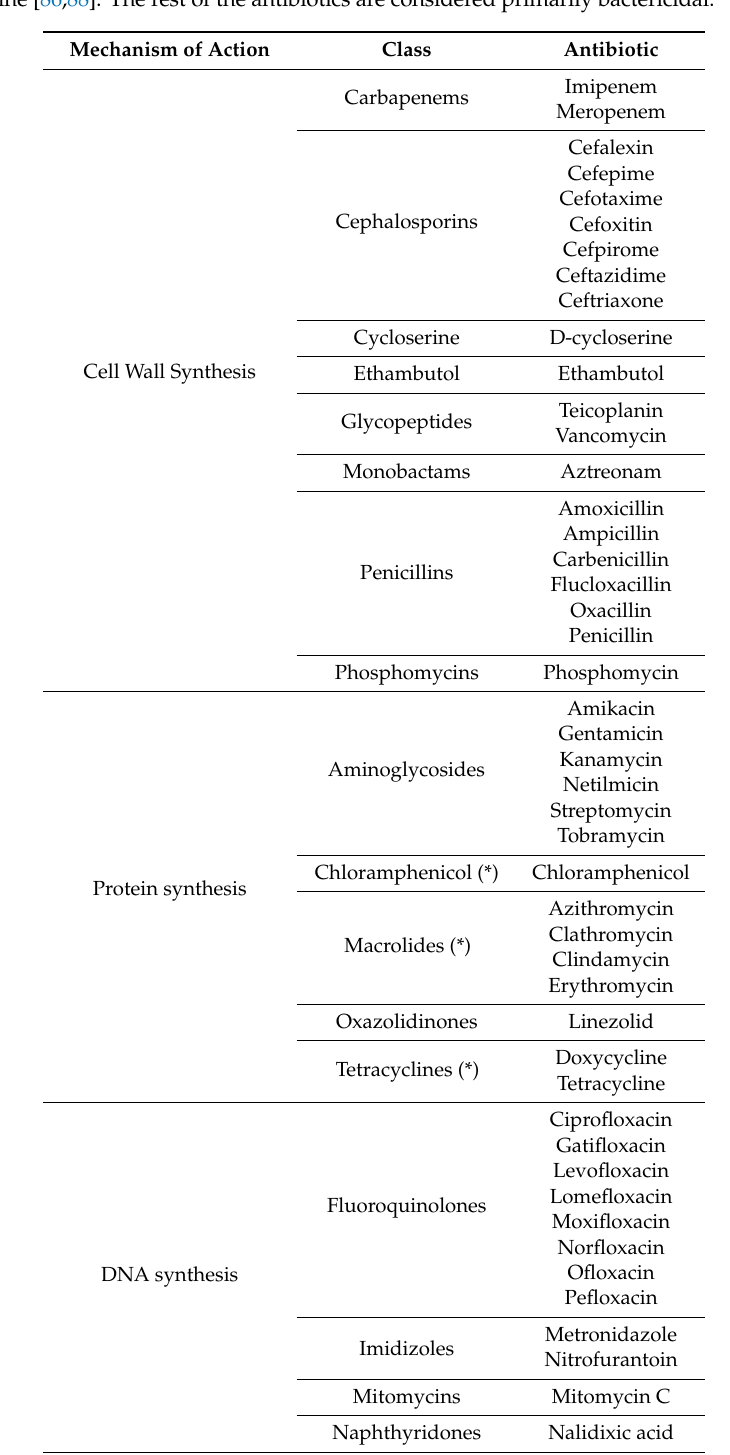
Table 2. Antibiotic classes. The first column lists the primary mechanism of action or target. The class groups some of the antibiotics based on their known chemical similarity. We do not include mixtures containing, e.g., the penicillinase inhibitor clavulanic acid. The count of antibiotics reached 54, which included one mixture of antifolates in trimethoprim-sulfamethoxazole (TSM). In some publications, this mixture was denoted as Co-trimazol, which here was included in the TSM tally. (*) Antibiotics